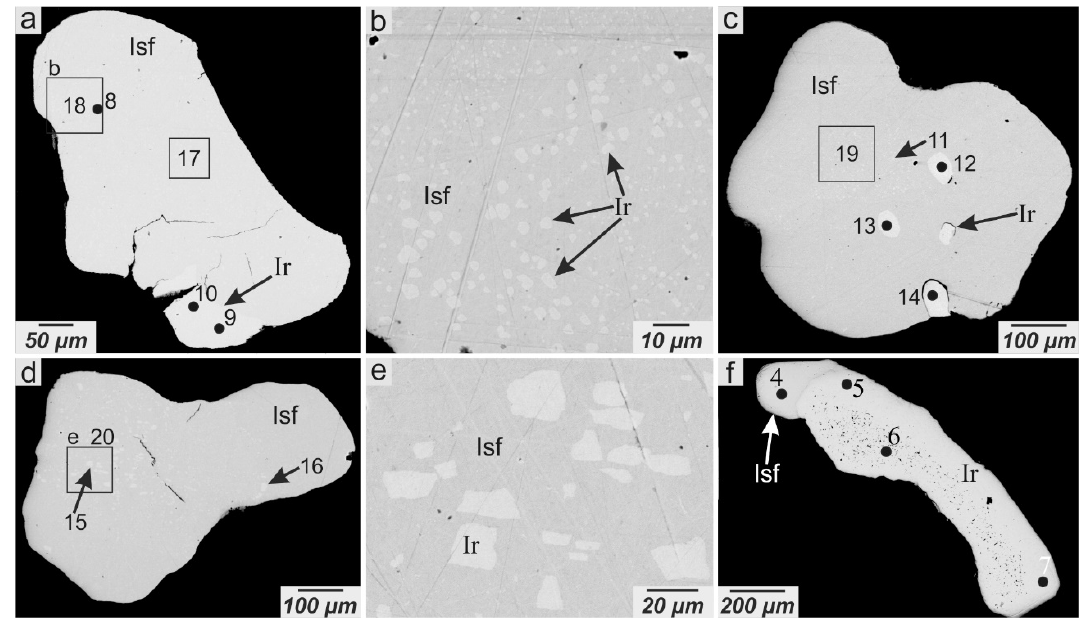
Figure 10. BSE images (SEM) of Ir exsolutions ( a – e ) in isoferroplatinum from the Glubokinskoe distal placer and ( f ) nugget of iridium from the Vershinniy eluvial placer. The number of points and fields corresponds to the analyses in Table 4 (No. 4–6, 8–20). The figures b and e are magnifications of figures a and d , respectively. Isf—isoferroplatinum, Os—osmium, Ir—iridium. The f photo was published in Reference